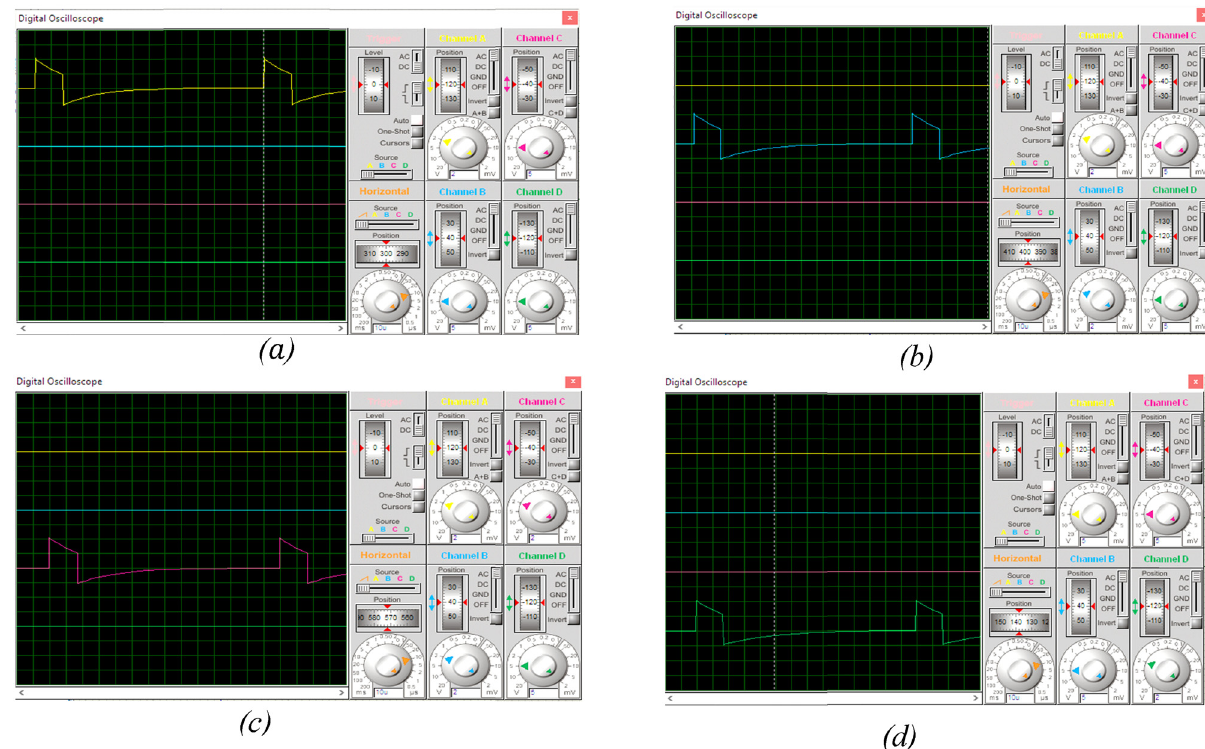
Figure 7: PD signals due to the e ff ect of the calibrating capacitors ( spherical ) . ( a ) PD signal with respect to C 1 . ( b ) PD signal with respect to C ( c ) PD signal with respect to C 2 .